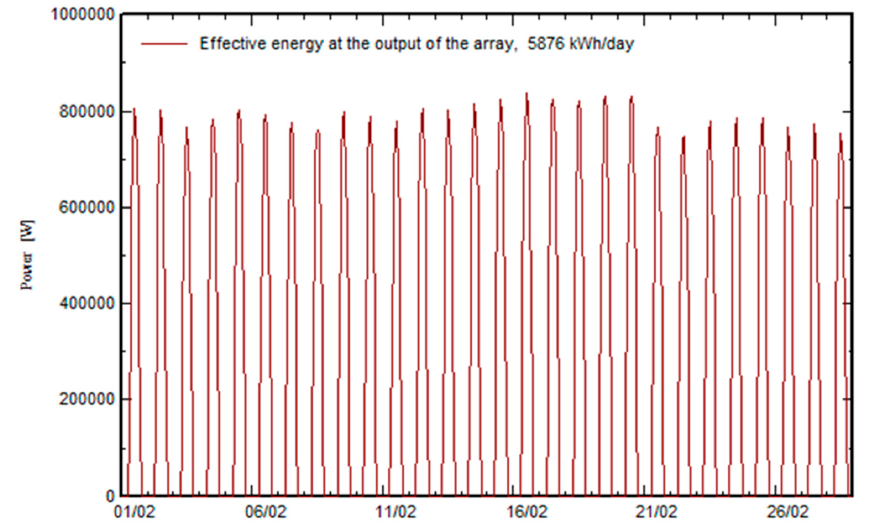
Figure 7. Energy injected into the grid in the month of February.